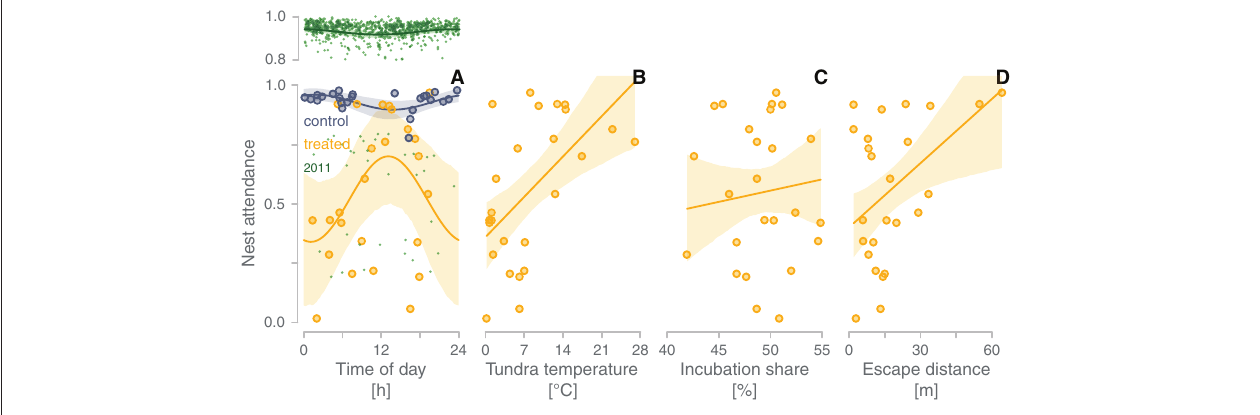
FIGURE 5 | Correlates of compensation for the absence of the partner. (A–D) Relationships between nest attendance (proportion of the total time the bird is on the nest) during the time the removed partner would have incubated (treated period) and the mid-time of this treated period (A) , the median tundra temperature at the nest during the treated period (B) , the focal parent’s share of incubation during the before-experimental period (C) , and its median escape distance from the nest prior to the experiment (D) . Yellow dots represent individual observations ( N = 25); yellow lines with yellow-shaded areas indicate model predictions with 95%CI for the treated period (Table S2 in Bulla, 2019) from a univariate model (A) and from a model containing temperature, incubation share and escape distance ( B–D ; the effects of other predictors were kept constant). (A) To emphasize how the relationship of nest attendance with time of day differs between the treated period and the natural, undisturbed situation, we added the observations and predictions from the control period (i.e., the regular incubation bout of the focal parent; blue-gray) and from non-experimental nests from the 2011 breeding season (green, to avoid cluttering data between 0.8-1.0 are shown in a separate, upper panel; Table S3 in Bulla, 2019 ; the 2011 data come from Bulla et al., 2013, 2014). (D) Note that escape distance estimates were unrelated to the number of times we visited the nest (i.e., how often the focal parent had seen us prior to the experiment; linear model estimate = − 0.8m, 95%CI: − 5 to 4m) and that the number of visits also did not explain variation in the level of compensation (1%, 95%CI: − 7 to 9%). Also, the time when we trapped the focal parent was unrelated to compensation (Figure S5 in Bulla, 2019 ).